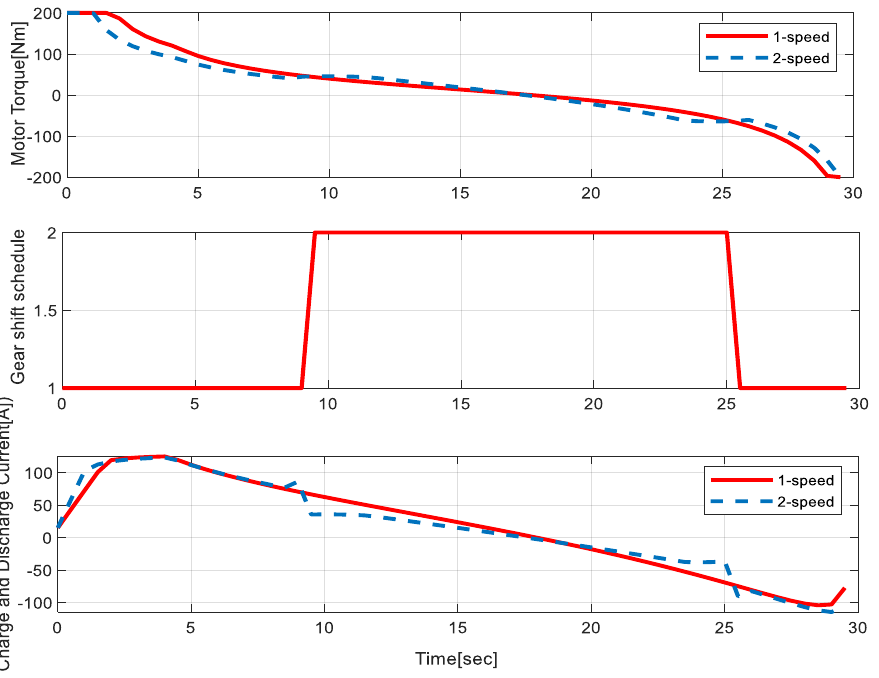
Figure 8. Comparison of system state trajectories under different gearboxes.